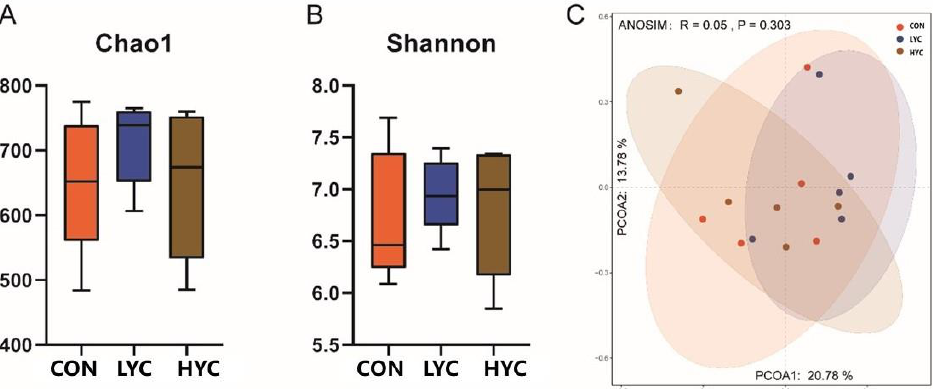
Figure 2. Effect of yeast culture supplementation on microbial diversity and structure. CON, control (basal diet supplied with 0 g/d yeast culture at the whole stage); LYC, low dose yeast culture (basal diet supplied with 10 and 20 g/d yeast culture at the early and late stages, respectively); HYC, high dose yeast culture (basal diet supplied with 20 and 40 g/d yeast culture at the early and late stages, respectively). ( A ) the richness of rumen microbiota. ( B ) The diversity of rumen microbiota. ( C ) The principal coordinate analysis (PCoA) based on the bacterial Bray–Curtis in each